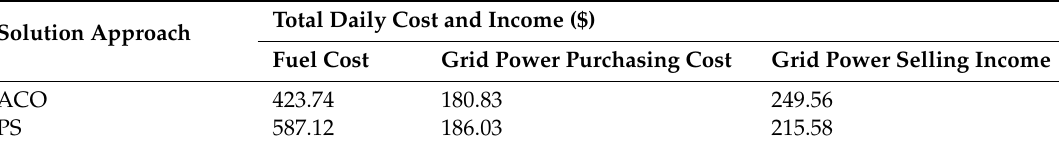
Table 4. Daily cost and income summary. PS: pattern search.